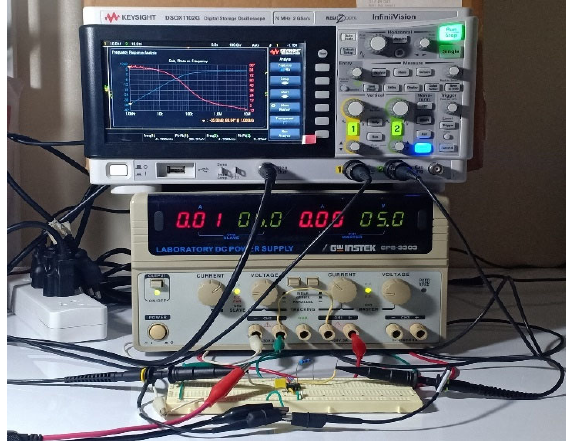
Figure 6. Experimental setup.